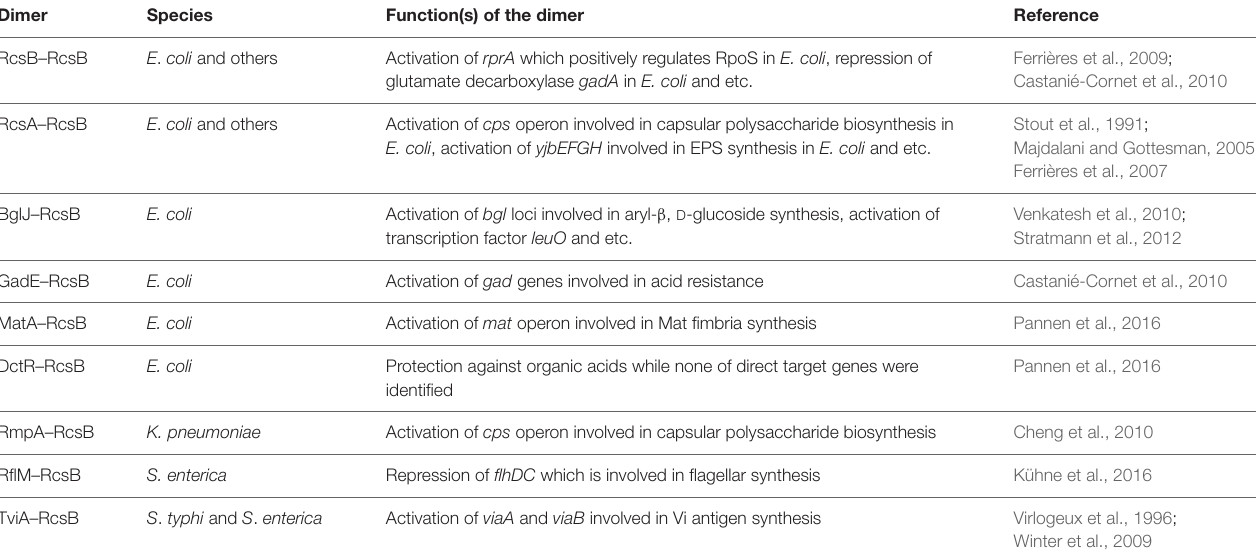
TABLE 1 | Homodimer and heterodimers of